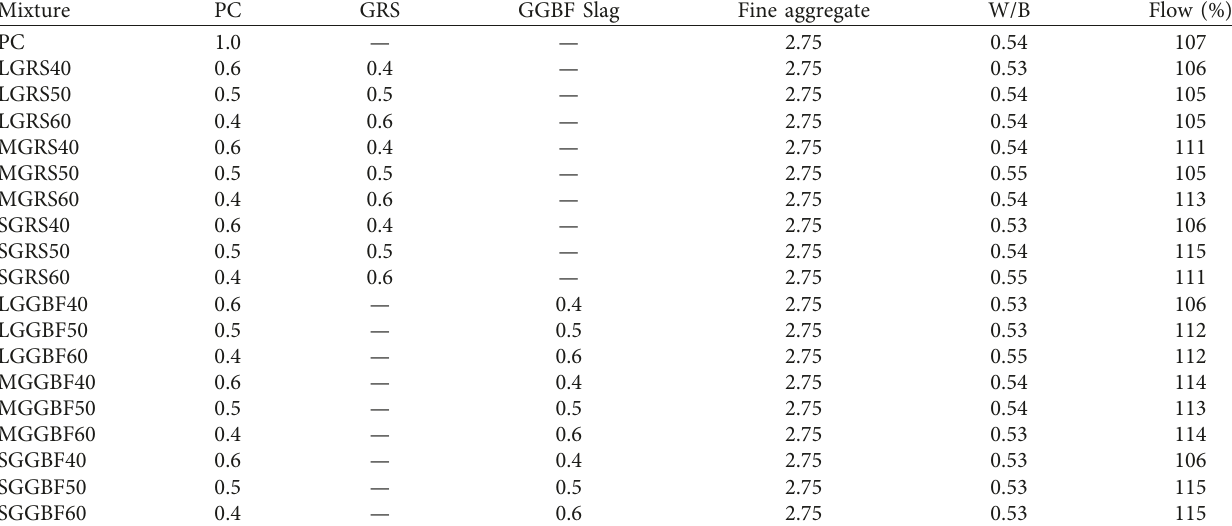
Table 4: Mix proportions of mortars by weight.